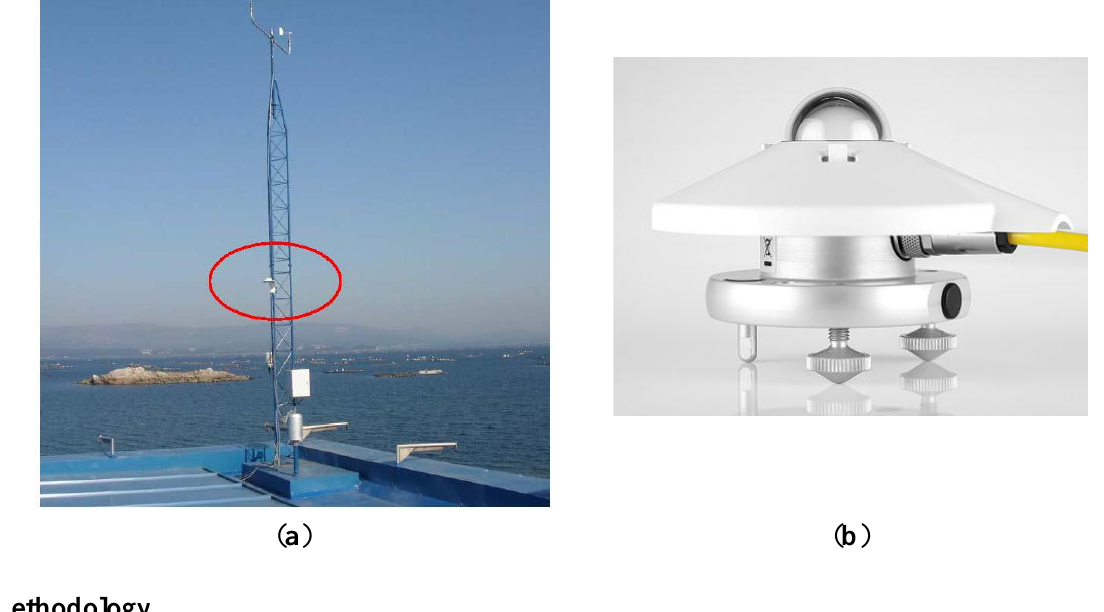
Figure 2. ( a ) Corón meteorological station with its thermopile pyranometer inside a circle. The model is the CMP-3 (source:www.meteogalicia.es); ( b ) Picture of the CMP-3 sensor taken from Kipp-Zonnen pyranometers